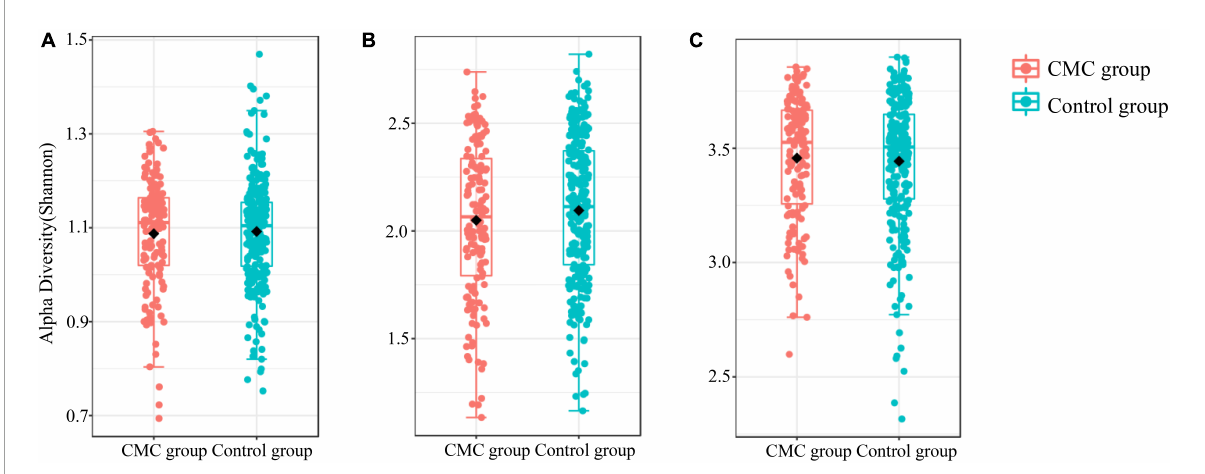
FIGURE1 Alpha diversity of subjects grouped by CMC status. The (A–C) refer to the Shannon index of gut microbiota at different MAG levels. (A) Phylum, (B) Genus, (C) Species. Data were normalized via the TSS method.